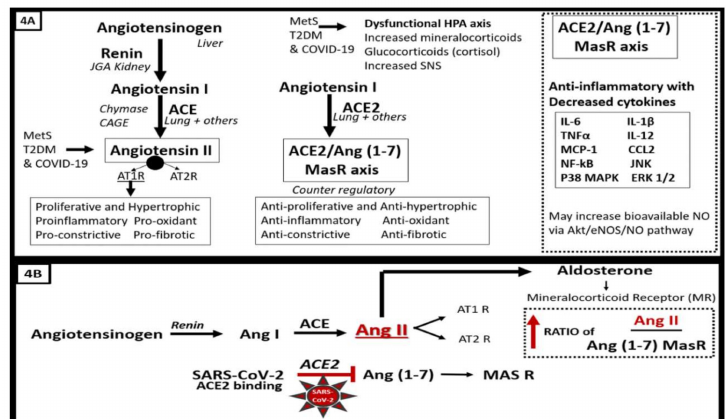
Figure 3. ( A , B ). The protective role of the ACE2–Ang (1–7)–MasR axis is attenuated and / or Lost in COVID-19 due to SARS-CoV-2 binding of ACE2 in pancreatic islets. Since SARS-CoV-2 in COVID-19 infections will bind to the ACE2 enzyme in order to gain entry into the β -cells once viremia has occurred, the anti-inflammatory e ff ects will be less available to help prevent the proinflammatory e ff ects of ACE / Ang II and inflammation and fibrosis will prevail in the peri-islet and intra-islet regions along with the deposition of islet amyloid polypeptide (IAAP) and collagen types I and III (fibrosis). The binding of SARS-CoV-2 to ACE2 in the islet β -cells may be partially responsible for the elevated blood glucose during the acute / immediate phase of COVID-19 and also the increased insulin resistance that is known to occur in individuals with COVID-19. Further, in the convalescent period and into the late-complication phase of COVID-19, there may be an increased risk for the development of T2DM and progression from orally treated T2DM to an insulin-dependent type of T2DM. Therefore, the loss of the ACE2–Ang (1–7)–MasR axis is of critical importance in COVID-19 [19]. Dashed boxes indicate the loss of the ACE2–Ang (1–7)–MasR axis and their protective pathways. ACE = angiotensin-converting enzyme; AGE = advanced glycation end products; Ang II = angiotensin II; CAGE = chymostatin-sensitive angiotensin II-generating enzyme; ERK CCL2 = C-C motif chemokine 2; ERK 1 / 2 = extracellular signal-regulated kinase 1 / 2; HPA = hypothalamic–pituitary–adrenal axis; IL-1 β = interleukin-1beta; IL-6 = interleukin-6; IL-12 = interleukin-12; JNK = c-Jun N-terminal kinase; MasR = MAS-related G protein-coupled receptor; MCP-1 = monocyte chemoattractant protein 1; NF-KB = nuclear factor-kappa B; p38 MAPK = p38 mitogen-activated protein kinase; RAGE = receptor for AGE; RONS = reactive oxygen and nitrogen (nitrosative stress) species; TNF α = tumor necrosis factor